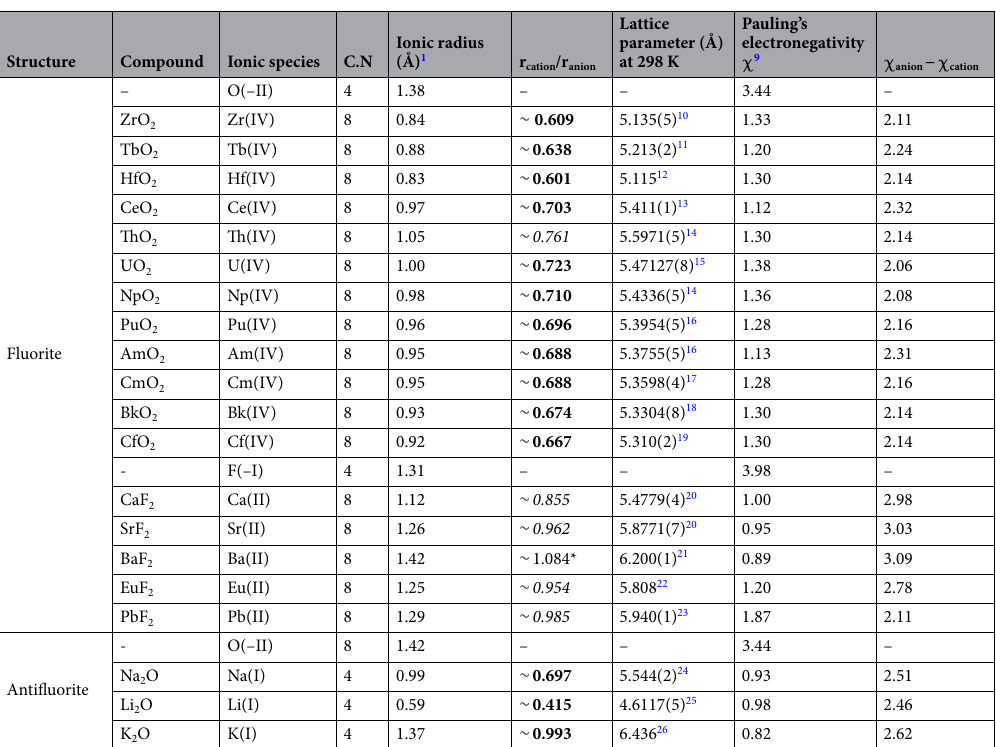
Table 1. Calculated r cation /r anion ratios from Shannon’s ionic radii 1 of selected fluorite and antifluorite- structured compounds and their experimental lattice parameters at room temperature determined using X-ray diffraction. *BaF 2 is a peculiar example as the cation is larger than the anion (r cation /r anion > 1). From a geometrical stability point of view, it shall be considered as an antifluorite as the smaller ion is in fourfold coordination instead of 8. The ratios highlighted in italic and bold correspond to the structures that respect and violate Pauling’s first rule, respectively. Pauling’s electronegativity χ 9 values and χ anion − χ cation are also